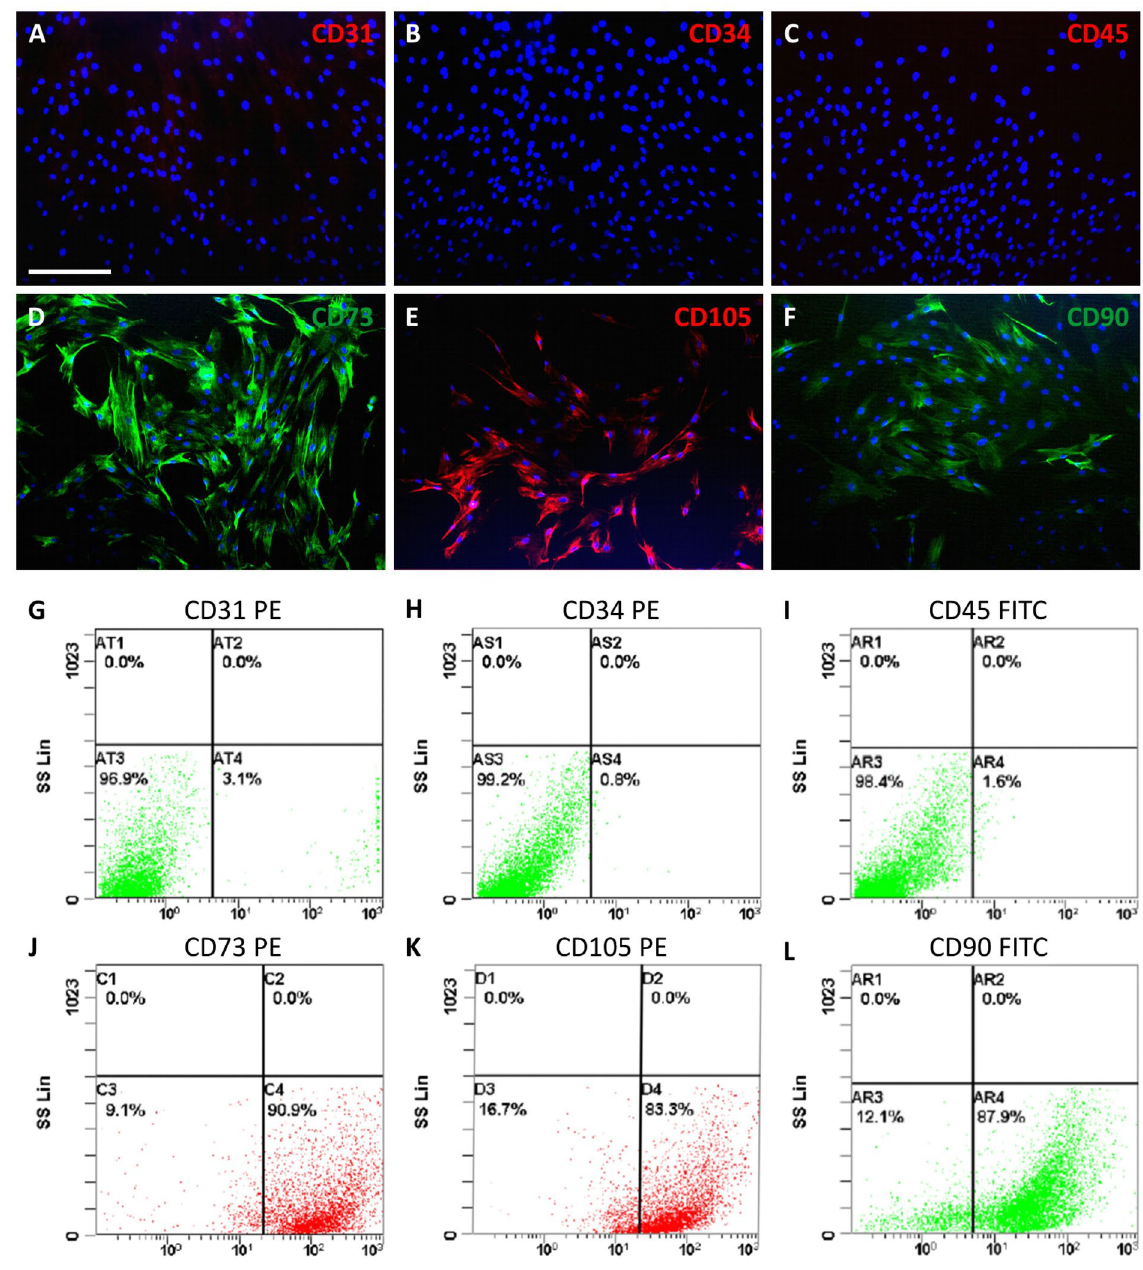
Figure 2. Phenotypic characterization of hADSCs by immunofluorescence and flow cytometry. Different samples were analyzed and, as expected, they didn’t exhibit any expression of CD31 ( A , G ), CD34 ( B , H ) or CD45 ( C , I ), whereas a strong expression of CD73 ( D , J ), CD105 ( E , K ) and CD90 ( F , L ) was found consistently. Scale bar in A for ( A – F ) 100 µ